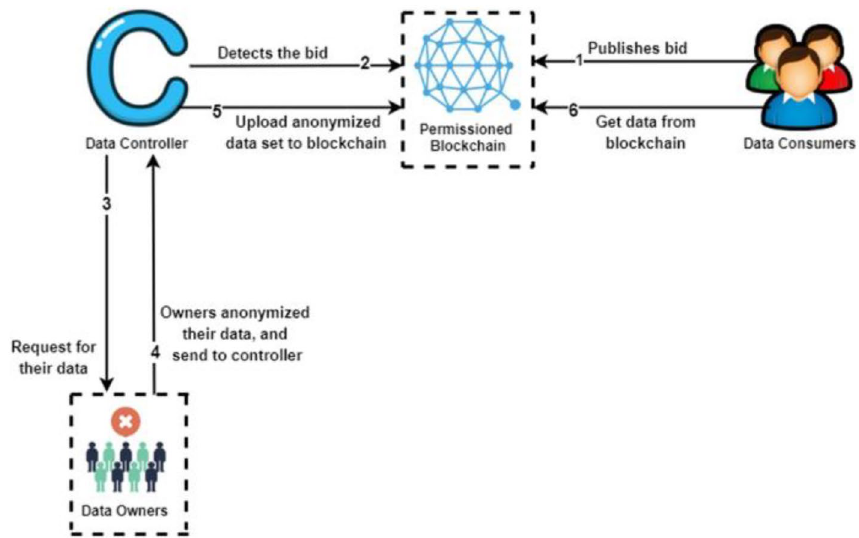
Figure 6. ShareChain data flow 8